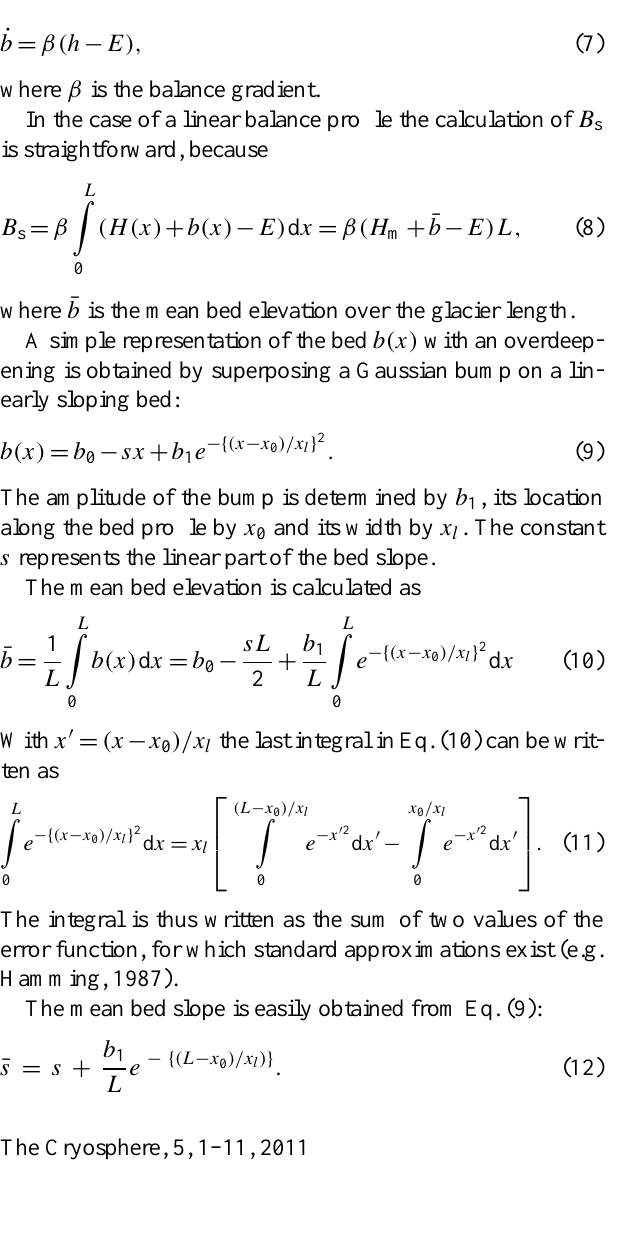
Fig. 4. Outline of the model for Hansbreen. The black dashed line is the bed elevation taken along a flowline (Fig. 2), whereas the blue line is the analytical representation used in the model. The red line shows an alternative profile used as a speculative approximation for the pre-Little Ice Age